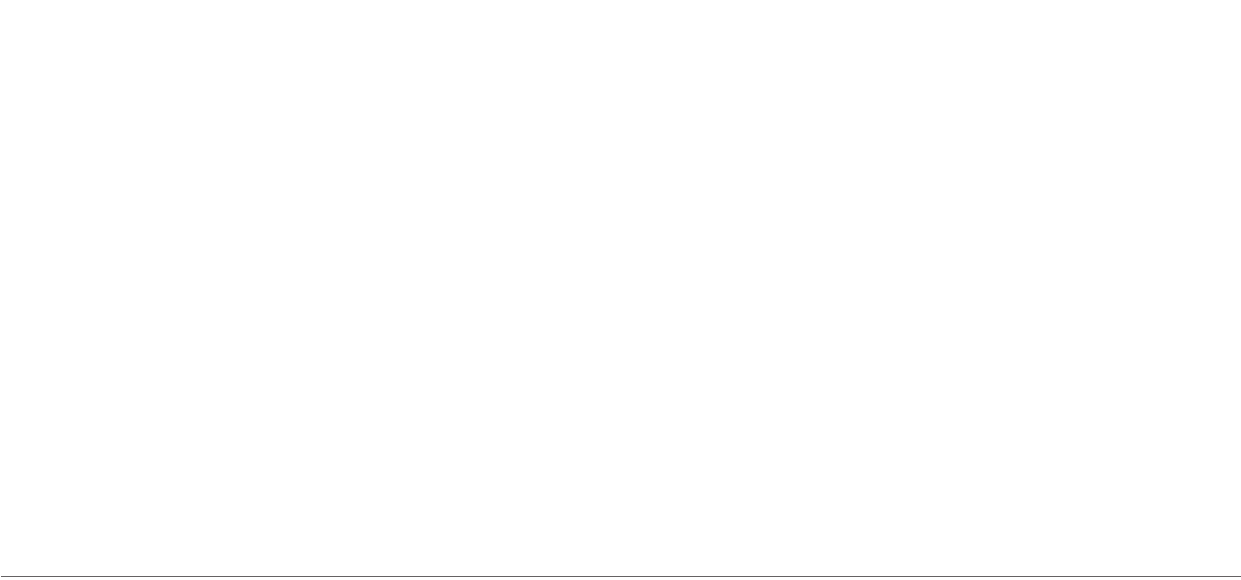
FIGURE A1 | Metabolic settings indicated by plots of f CO 2 (matm) vs. DO% (a) and Excess DIC ( µ mol kg − 1 ) vs. AOU ( µ mol O 2 kg − 1 ) (b)